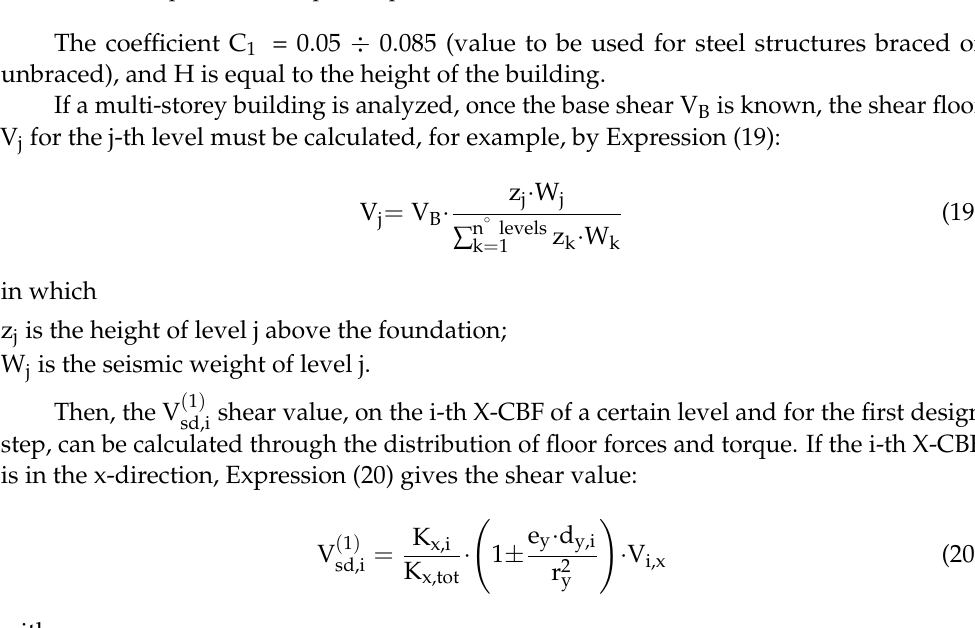
Figure 5. Differences between the dissipative and non-dissipative structure design methods in an Acceleration – Displacement Response Spectrum (ADRS) format chart.